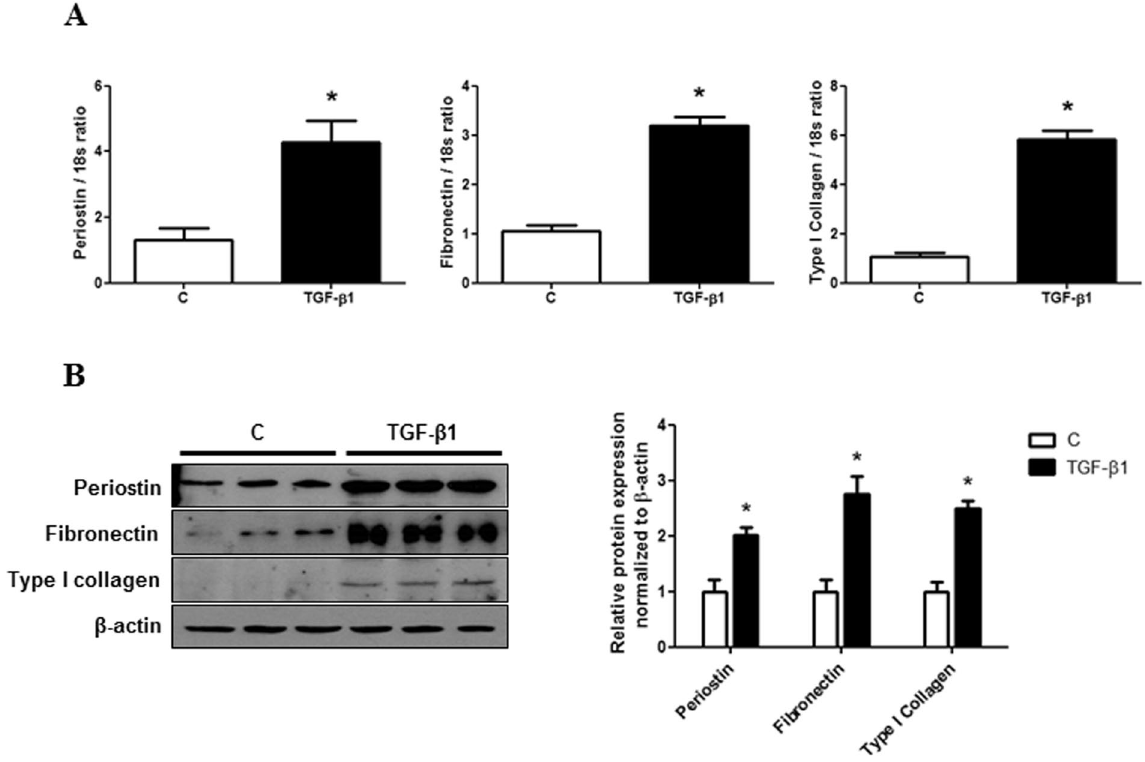
Figure 1. Periostin, fibronectin, and type I collagen expression in inner medullary collecting duct (IMCD) cells treated with or without TGF- β 1. ( A ) Periostin, fibronectin, and type I collagen mRNA levels (n = 6). Compared to control IMCD cells, periostin, fibronectin, and type I collagen mRNA expression were significantly increased in TGF- β 1-treated cells (10 ng/ml). ( B ) A representative western blot analysis of periostin, fibronectin, and type I collagen protein (a representative of 4 blots). The protein expression of periostin, fibronectin, and type I collagen were increased significantly in IMCD cells exposed to TGF- β 1. Uncropped scans are presented in Supplementary Figure 2. C, control. * P < 0.05 vs.